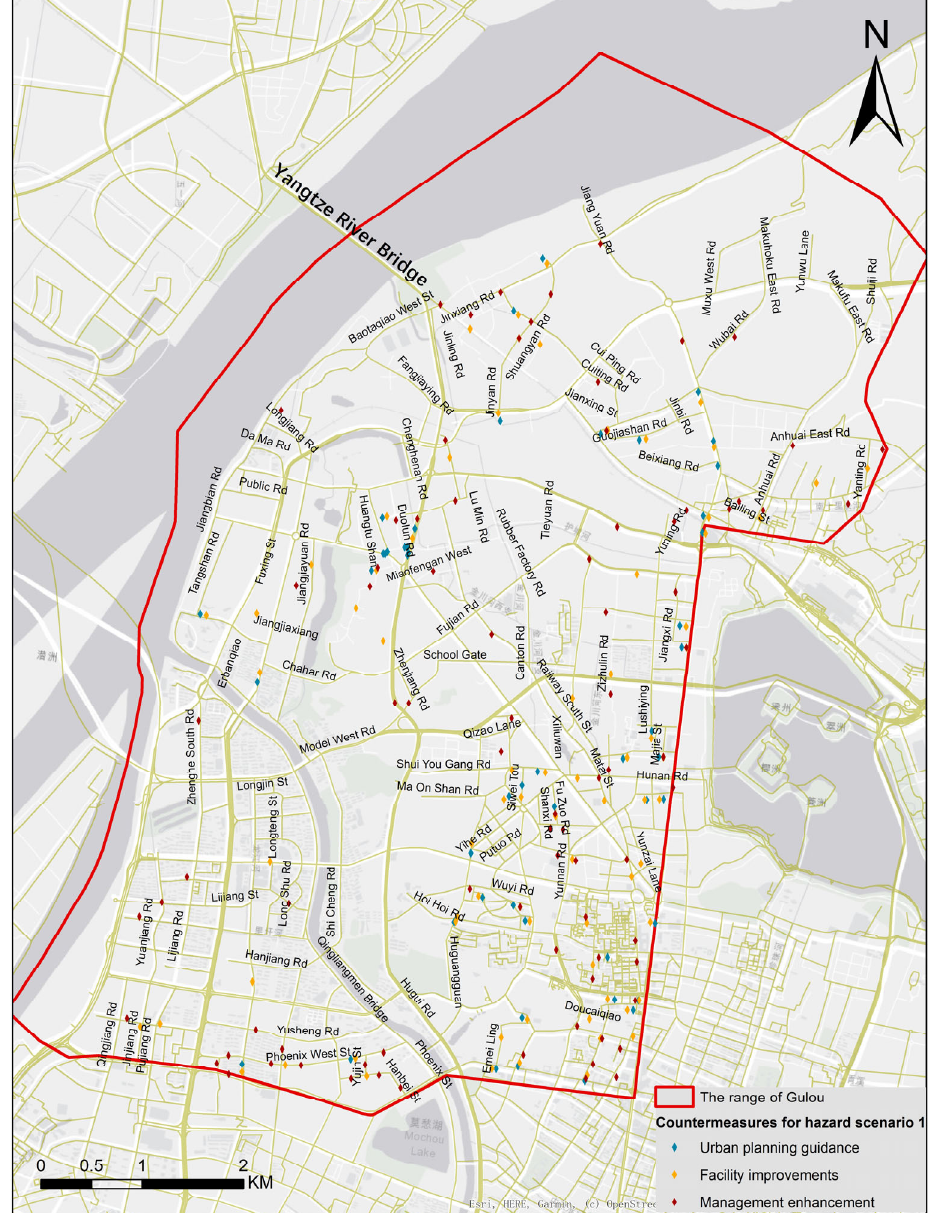
Figure 18. The countermeasures for HS1 in specific road sections.